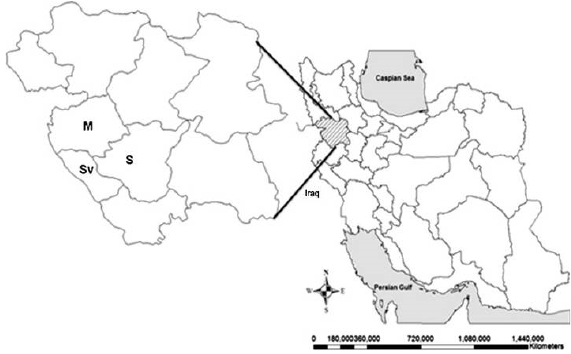
Fig. 1. The location of Sarvabad